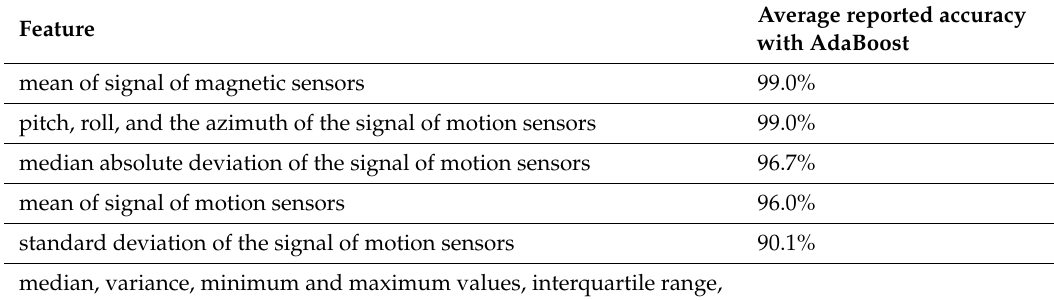
Table 3. Average of the accuracy reported in the studies analysed, grouped by features.